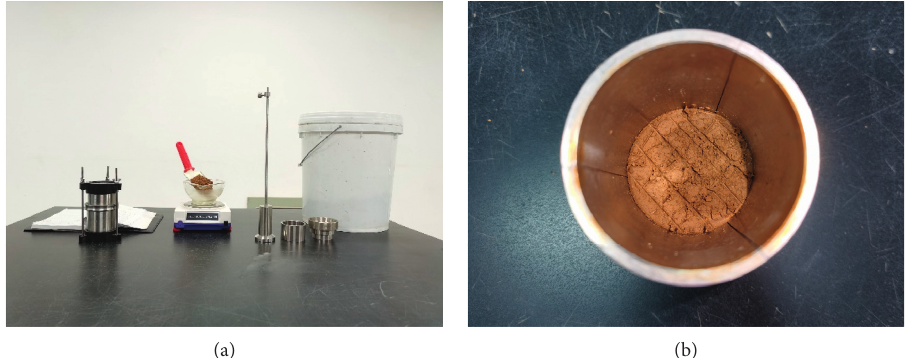
Figure 3: The procedures for preparing triaxial samples. (a) Sample weight. (b) The top of each layer was scarified prior to adding the next layer.